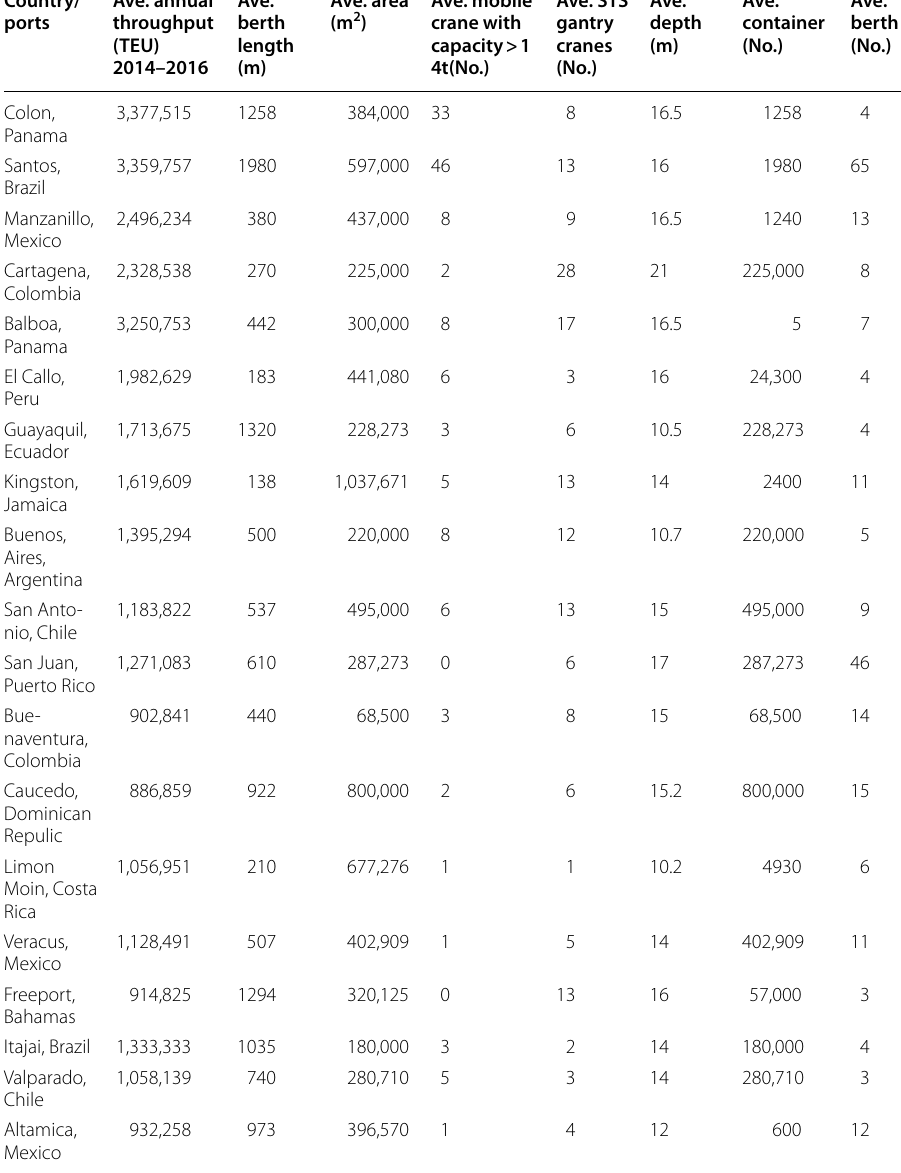
Table 9 Port characteristics of LAC average between 2014 and 2016 (Pre-PCE-Era). Source : Own elaboration based on data from World Port Source Country/